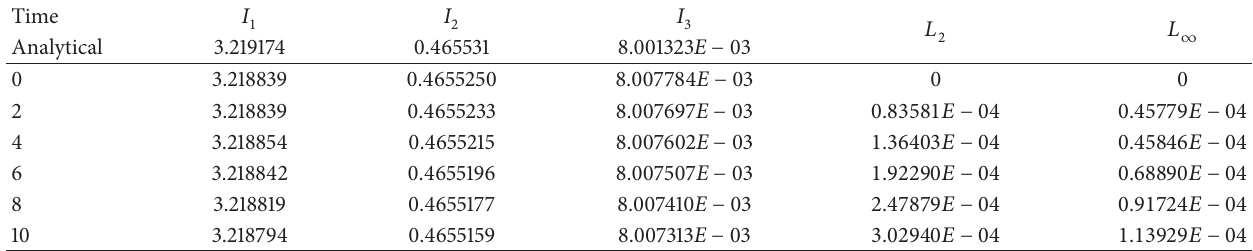
Table 1: Invariants and error norms for single solitary wave, 𝑐 = 0.05 , ℎ = 0.2 , 𝑘 = 0.2 , 𝑥 0 = 40 , and 0 ≤ 𝑥 ≤ 100 (using Crank-Nicolson time discretization).